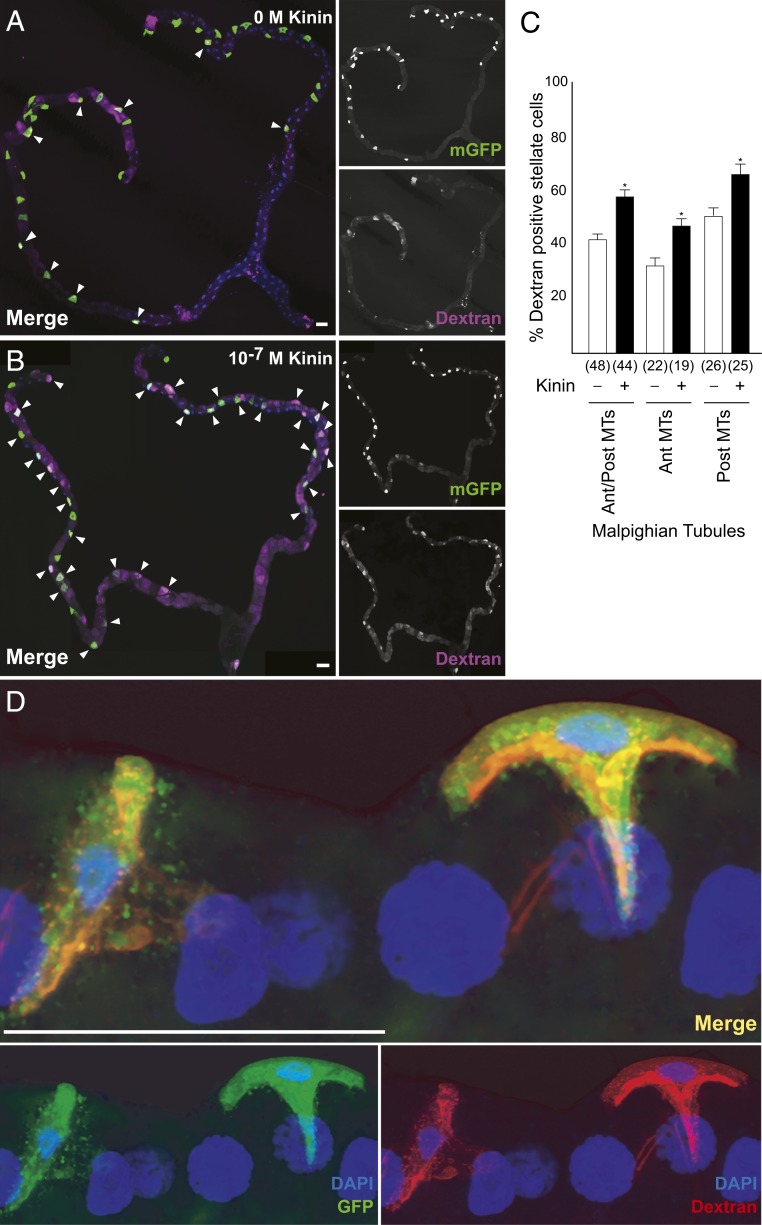
Dextran labeling demonstrates water flux specific to the stellate cells. Accumulation of dextran (A) of unstimulated and (B) following application of Kinin (10−7 M) in tubule expressing mGFP in stellate cells. Because of the length of the tubule, B is a photomontage of 3 fields, all captured with the same microscope settings. (C) Quantification of dextran labeling. Data are expressed as percentage of dextran-positive stellate cells in response to 10−7 M Kinin compared to unstimulated tubule ± SEM (n = 44 to 48). *P < 0.05 (Student’s t test). (D) Maximum Z projection of tubules after application of 40 kDa of dextran conjugated to TRITC dye (red) to tubules in which stellate cells are expressing GFP (green) confirmed the accumulation of dextran to the stellate cell; DAPI, blue. (Scale bars, 50 μm.)